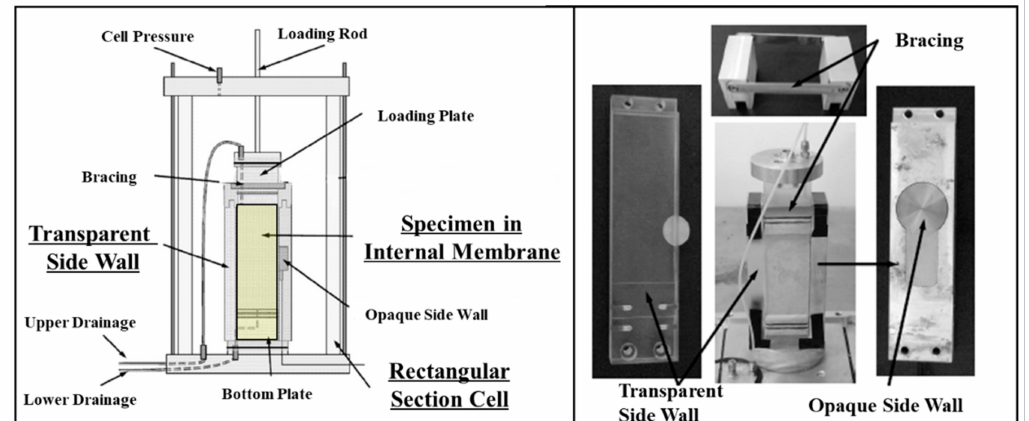
Figure 1. Plane strain testing apparatus.